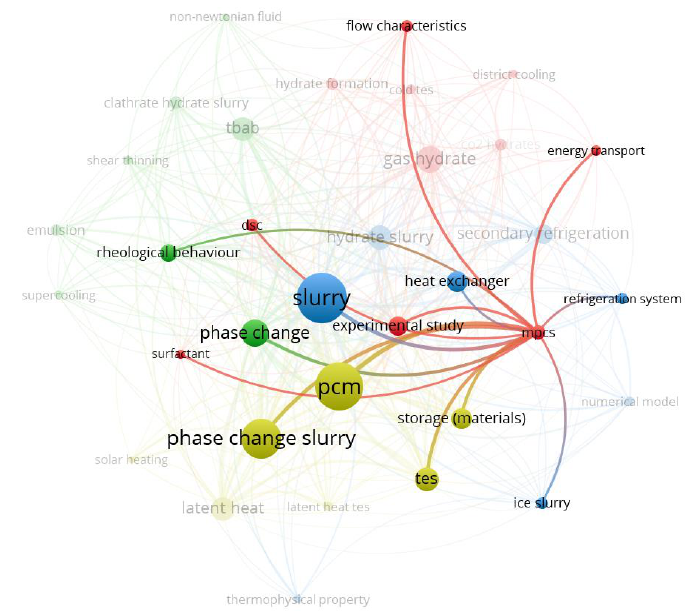
Figure 7. Co-occurrence of the keyword Figure 7. Co- occurrence of the keyword “mpcs” .